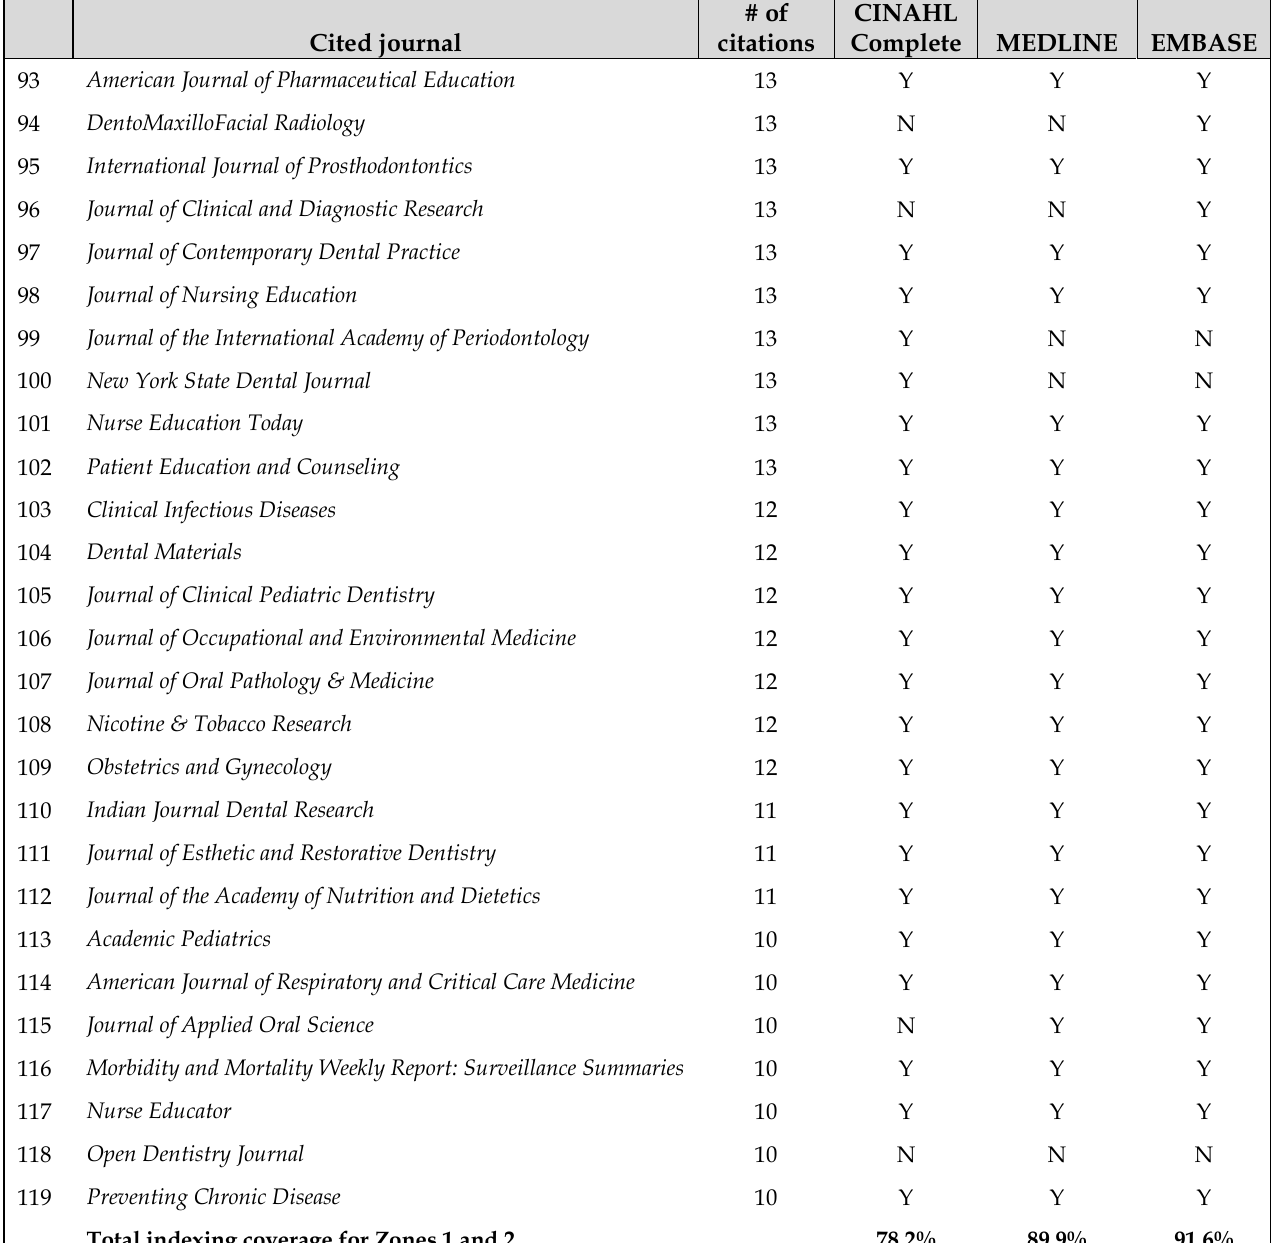
Table 4 Distribution and indexing coverage in of cited journals in Zone 1 and Zone 2